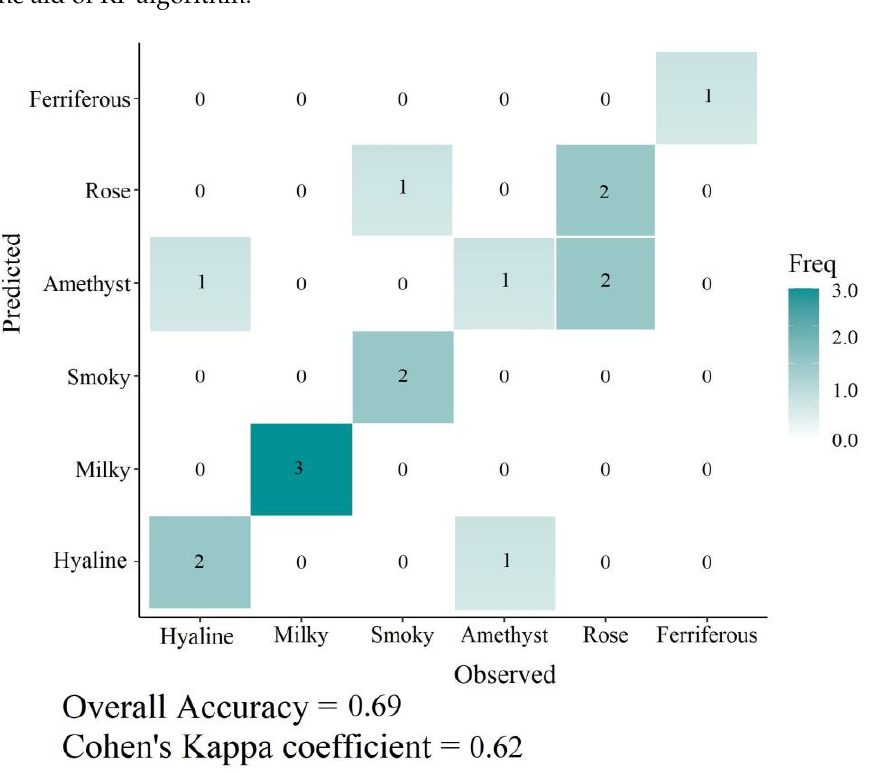
Figure 5. Confusion matrix of quartz varieties prediction model based on Random Forest algorithm and accuracy. Freq = absolute frequency.